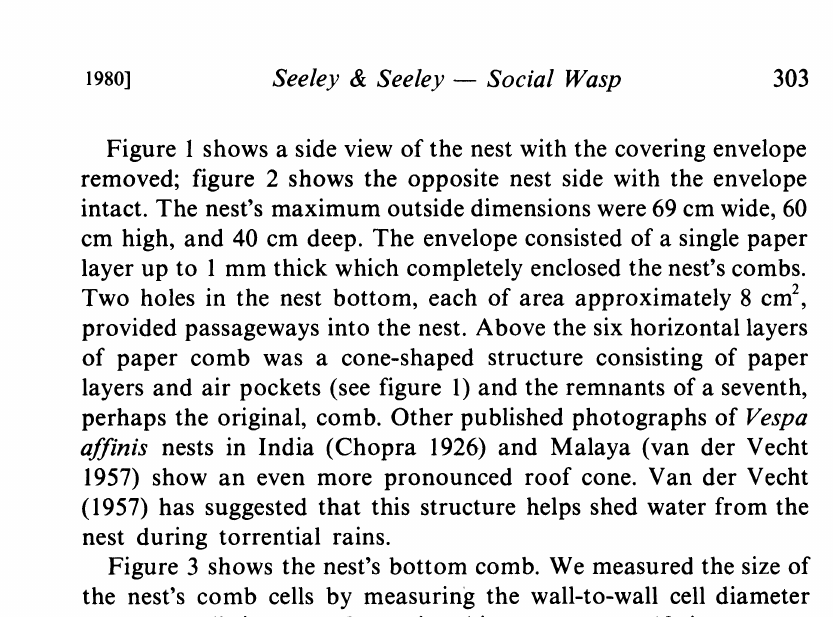
shows a side view of the nest with the covering envelope removed; figure 2 shows the opposite nest side with the envelope intact. The nest’s maximum outside dimensions were 69 cm wide, 60 cm high, and 40 cm deep. The envelope consisted of a single paper layer up to mm thick which completely enclosed the nest’s